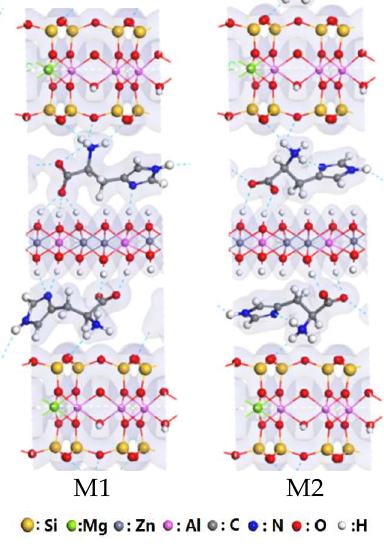
Figure 8. Simulations of charge density of M1 and M2.